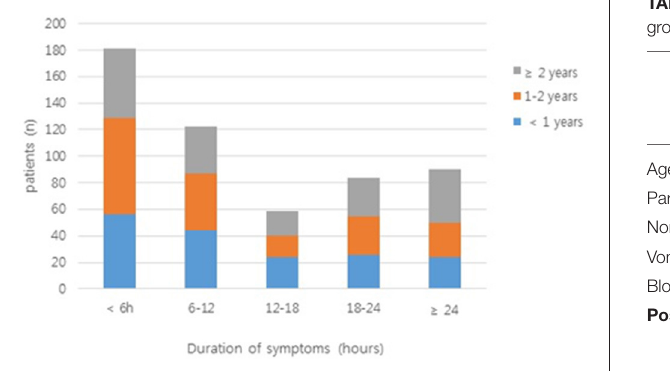
FIGURE 2 | The duration of symptoms in patients enrolled in the study. Bars are colored according to the number of patients from each age group ( < 1 year, 1–2 years, and ≥ 2 years).